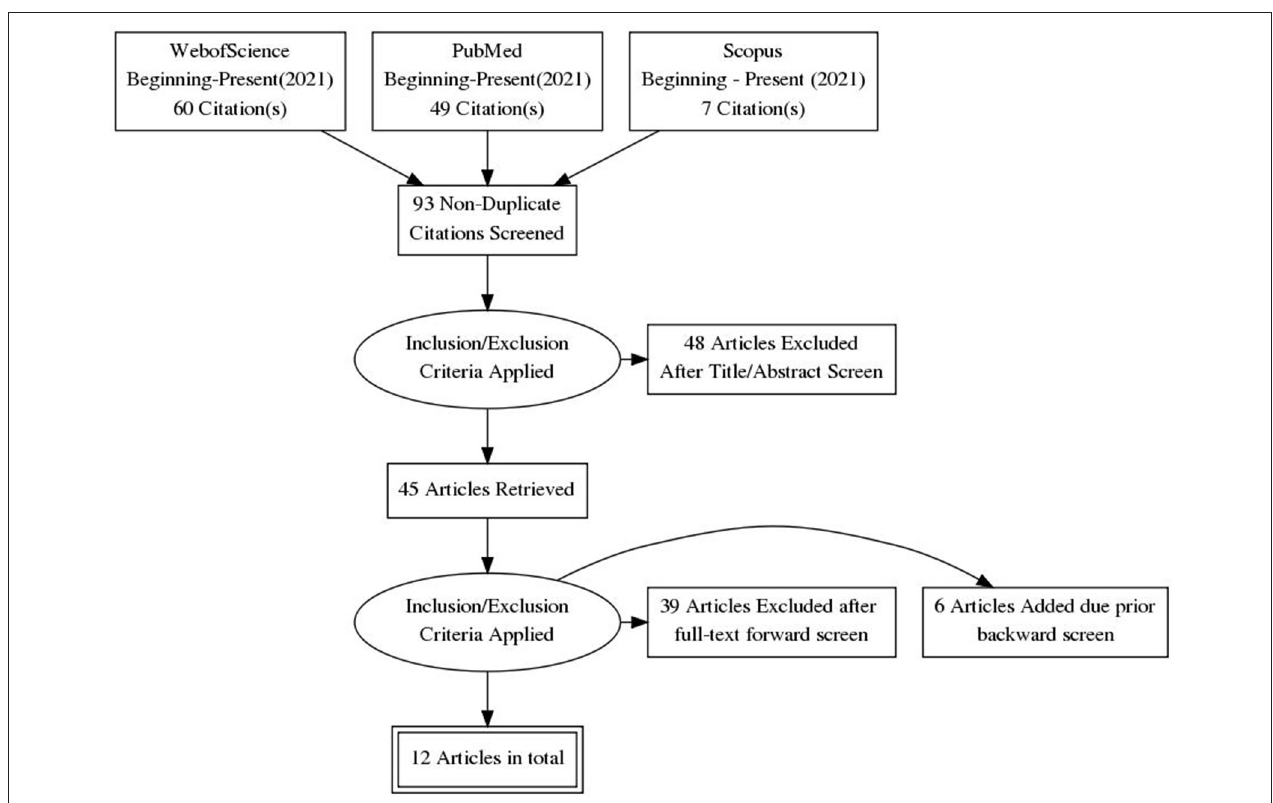
FIGURE 1 | The diagram depicts the process of selecting relevant studies that consider the ethical aspects of citizens involvement in planning stages of research. It is prepared in accordance with the PRISMA standards for selection of studies and reporting of items for systematic reviews and meta-analyses. The targeted search through comprehensive databases (Web of Science, Scopus, and PubMed), was followed by screening of retrieved studies, and concluded with final selection of relevant